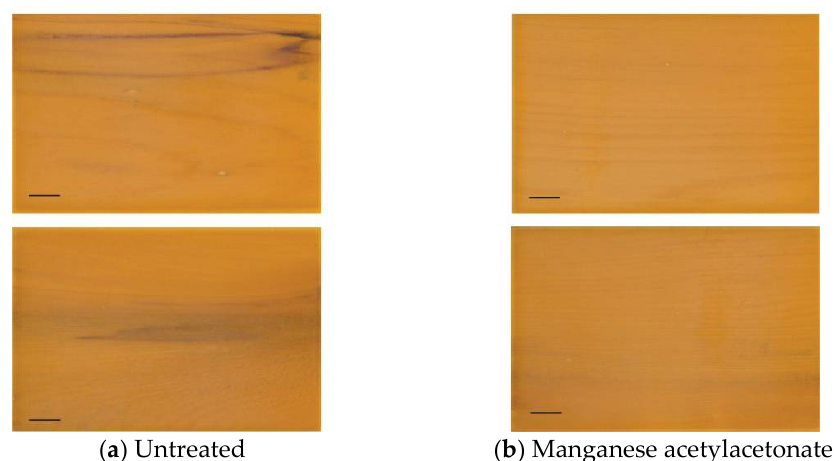
Figure 9. Appearance of wood in two untreated ( a ) (left, top and bottom) and two manganese acetylacetonate treated ( b ) (right, top and bottom) yellow cedar panels finished with a clear polyurethane coating and exposed to artificial accelerated weathering for 2500 h. Note that darkening of wood is less pronounced in panels treated with manganese acetylacetonate. Scale bars = 10 mm.